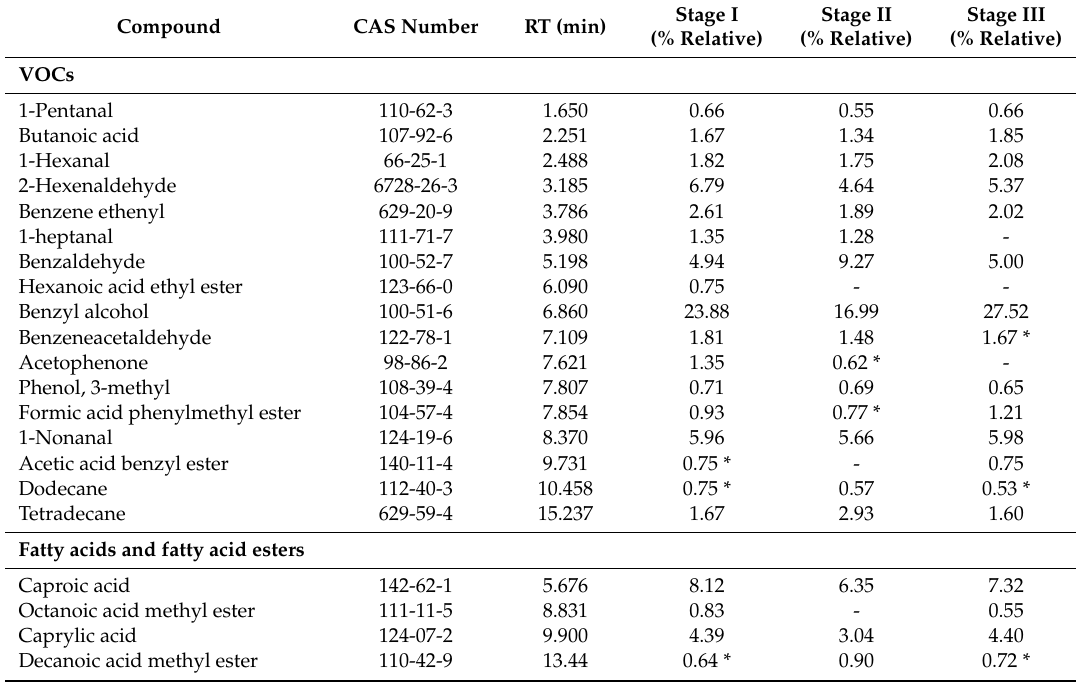
Table 2. List of compounds with quality higher than 80 with percentage contribution to total area of all peaks of volatiles compounds of the Aloe vera flowers at three maturity stages. Stage I: immature; stage II: mature; stage III: mature with stamens exposed to the